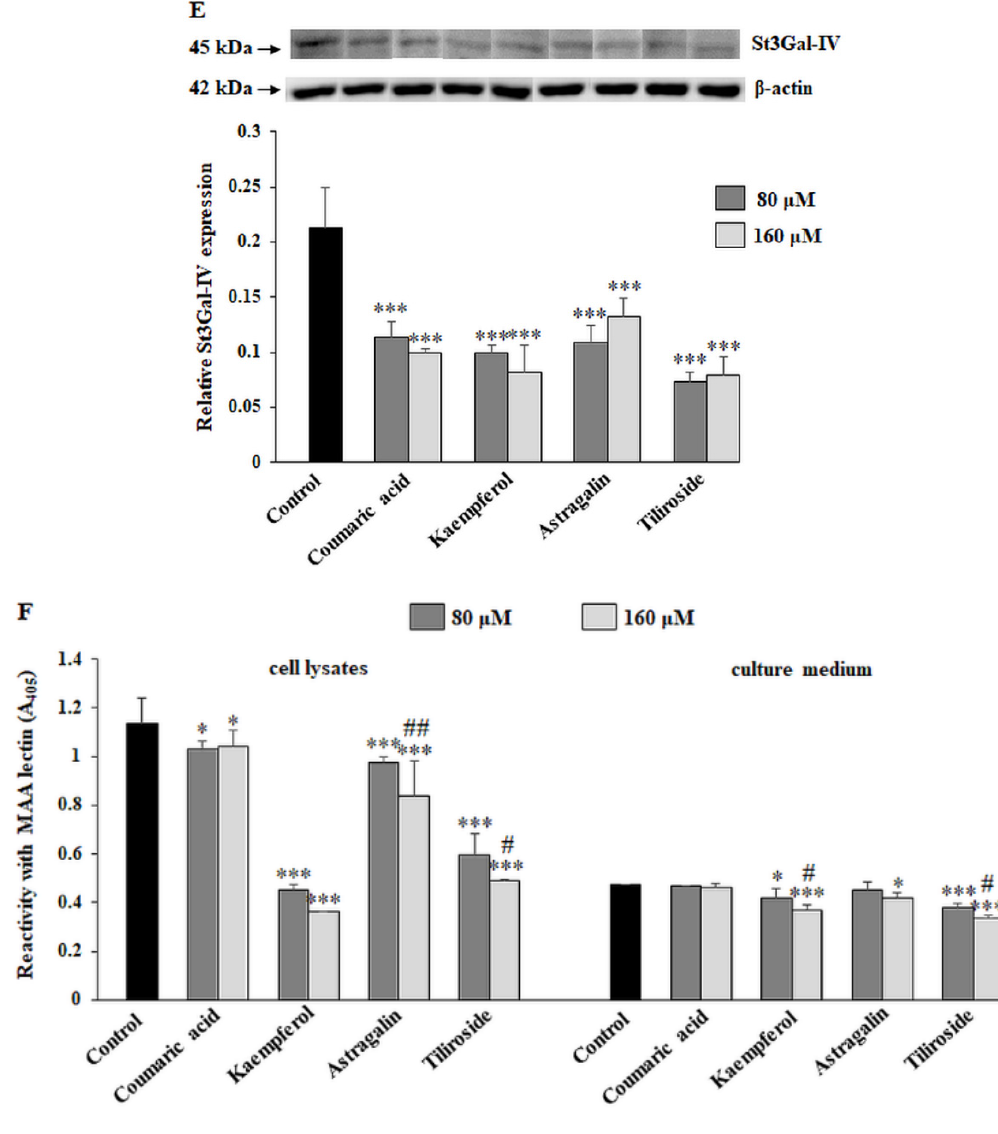
Figure 5. The effect of coumaric acid, kaempferol, astragalin and tiliroside on C1GalT1 mRNA, C1GalT1 protein, T antigen in cell lysates and culture medium, ST3GalT1 mRNA, St3Gal-IV protein and sialyl T antigen in cell lysates and culture medium. The AGS cancer cells were incubated for 24 h with 80 and 160 µ M concentrations of the polyphenolics. mRNA was determined by RT-PCR (( A ) for C1GalT1 and ( D ) for ST3GalT1). The results are shown as a relative fold change in mRNA expression of genes in comparison to the genes in control, where expression was set at 1. ± SD are the mean of triplicate cultures. * p < 0.05, ** p < 0.01, *** p < 0.001 compared to untreated control; # p < 0.05, ## p < 0.01, ### p < 0.001 compared to lower concentration (80 µ M) of specific polyphenolic compound. C1GalT1 ( B ) and St3Gal-IV ( E ) protein expressions were assessed by Western blot analysis. β -actin served as a protein loading control. The intensities of the bands were quantified by densitometric analysis. Data represent the mean ± SD of triplicate culture. * p < 0.05, ** p < 0.01, *** p < 0.001 compared to untreated control. T and sialyl T antigens’ relative expressions in cell lysates and culture medium were analyzed by ELISA tests with biotinylated lectins (PNA recognizing T structure ( C ) and MAA recognizing sialyl T antigen ( F )). The results are expressed as absorbance at 405 nm after reactivity with proper lectin. Values ± SD are the mean from three independent assays. * p < 0.05, ** p < 0.01, *** p < 0.001 compared to untreated control; # p < 0.05, ## p < 0.01 compared to lower concentration (80 µ M) of specific